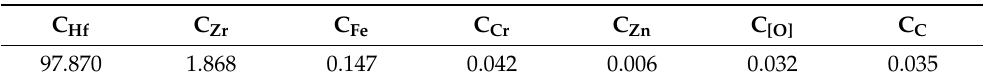
Table 1. Chemical composition of technogenic hafnium before being treated by electron beam melting and refining (in mass.